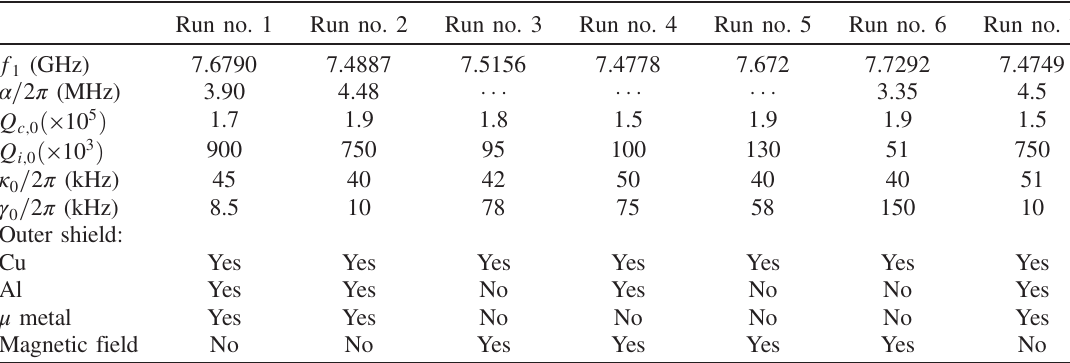
TABLE II. Summary of circuit parameters from all measurement runs: qubit frequency f 1 , external quality factor , internal quality factor (zero field) Q , external coupling rate (zero field) κ 0 , internal decay rate (zero field) Q c; 0 i; 0 (zero field) γ 0 , outer shielding configuration.